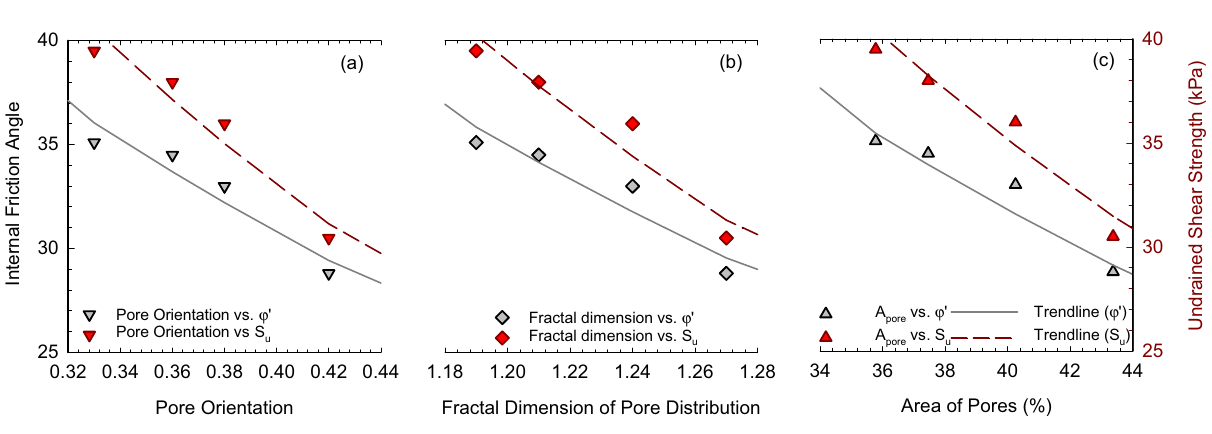
Figure 16. Internal friction angle and undrained shear strength versus pore index ( a ) pore orientation, ( b ) fractal dimension of pore distribution, and ( c ) area of